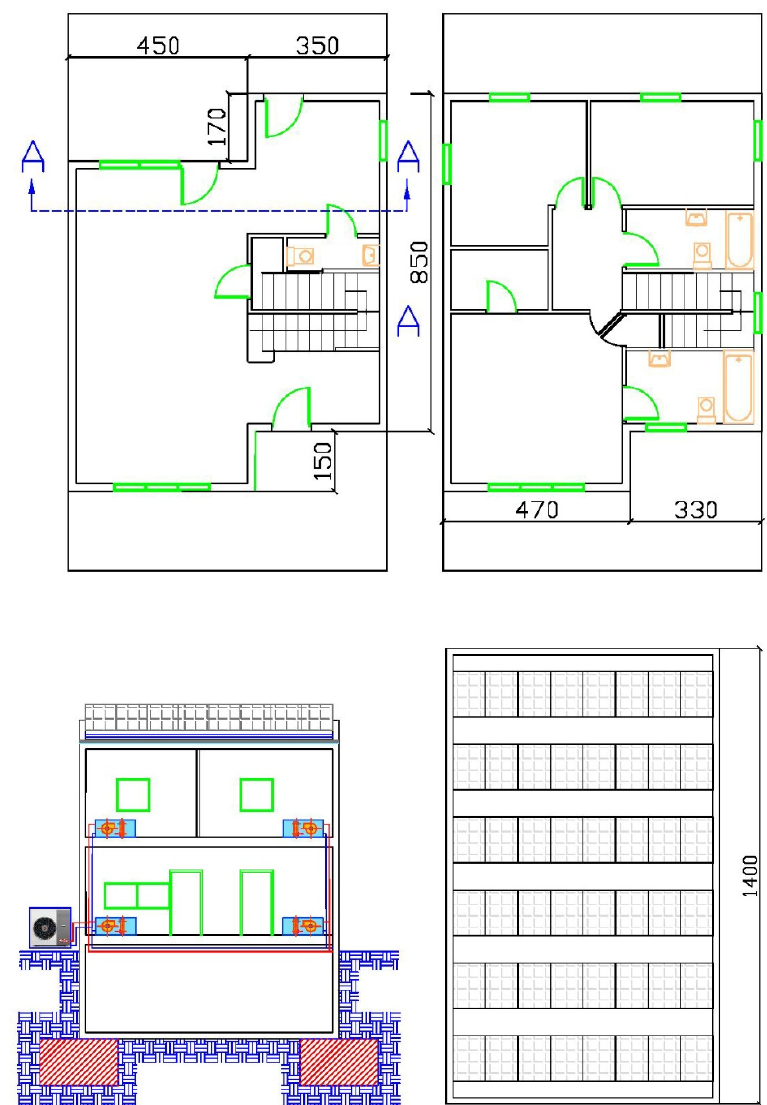
Figure 1. Layout drawing of the house employed in the simulations: Plan of ground level, first levels, section AA (reduced scale) and plan of the rooftop photovoltaic (PV) installation with maximum possible capacity. Table 1. Insulation data (U-values) for the building envelope (reinforced concrete